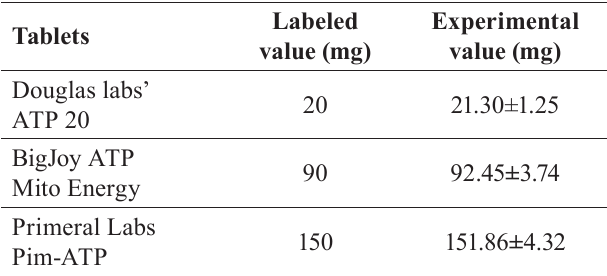
TABLE V - R esults of ATP determination in dietary energy